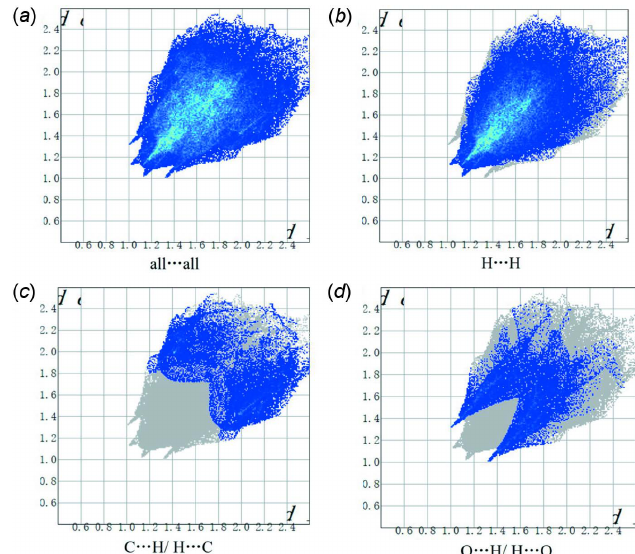
Figure 5 The two-dimensional fingerprint plots for the title compound, showing ( a ) all interactions, and delineated into ( b ) H (cid:3)(cid:3)(cid:3) H, ( c ) C (cid:3)(cid:3)(cid:3) H/H (cid:3)(cid:3)(cid:3) C and ( d ) O (cid:3)(cid:3)(cid:3) H/H (cid:3)(cid:3)(cid:3) O interactions. The d i and d e values are the closest internal and external distances (in A˚ ) from given points on the Hirshfeld